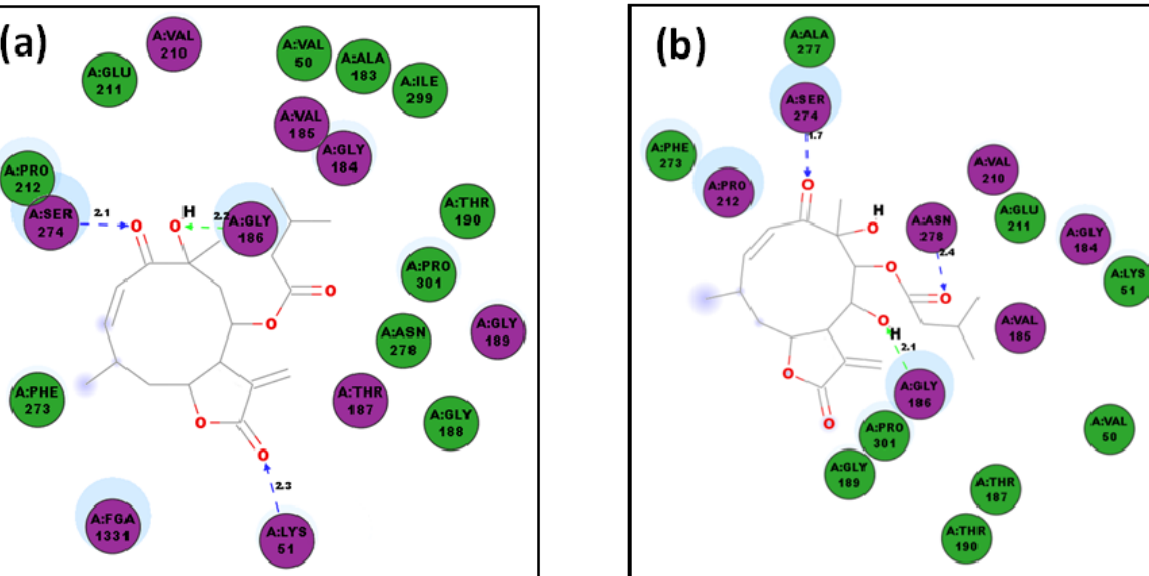
Figure 13. 2D representation of protein ligand interactions with Lm CS of: ( a ) compound 83 ; ( b ) compound 81 .